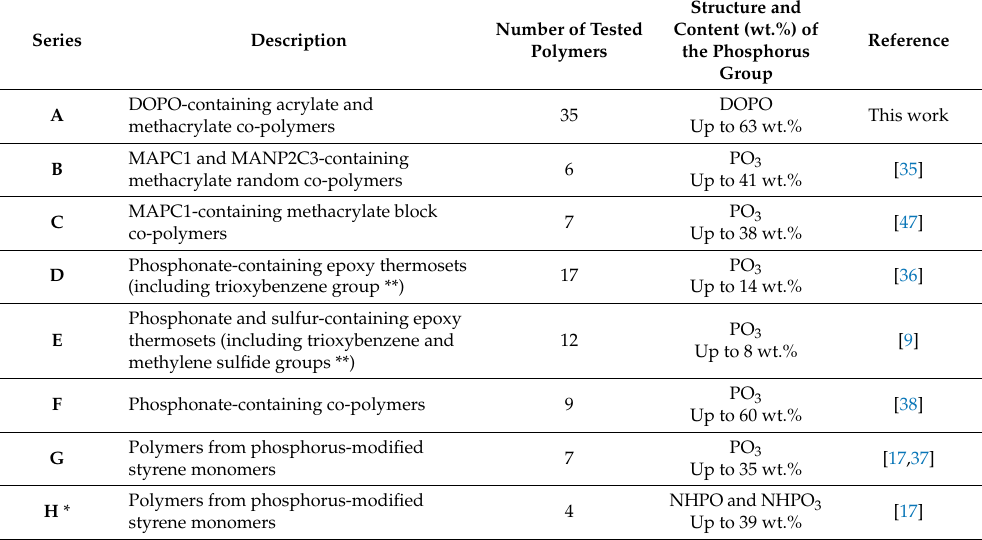
Structure and Number of Tested Content (wt.%) of Polymers